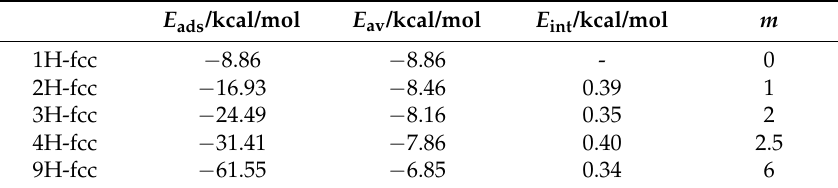
Figure 8. Models for calculating the lateral interaction energy of H(a) on Pt(111). Table 2. Parameters of lateral interaction energy among H(a) adatoms.